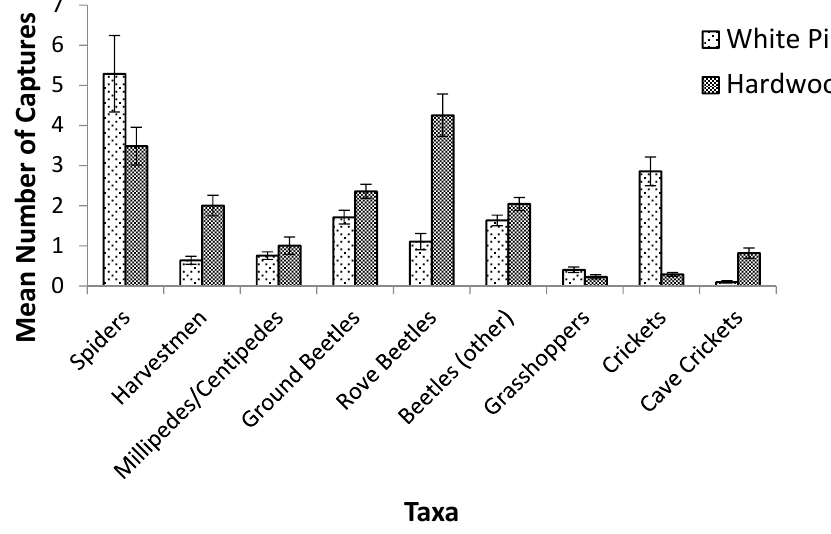
Figure 3. Mean ( + SE) number of invertebrate captures by forest type in 10 harvested sites in western North Carolina (2016–2017).